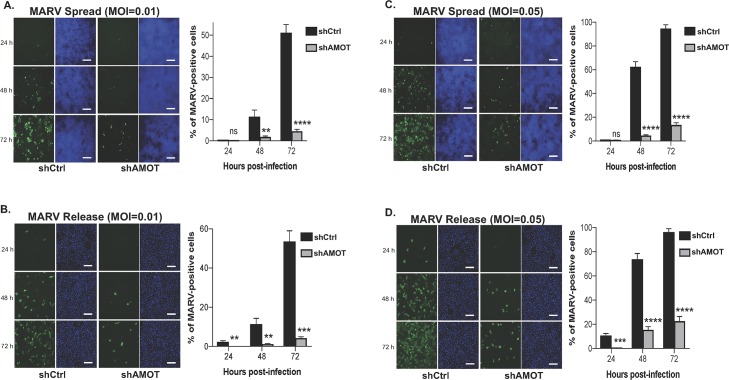
Spread and release of live MARV from shCtrl or shAmot cells.shCtrl or shAmot cells were infected with MARV at an MOI of either 0.01 (A and B), or 0.05 (C and D), and both virus spread (A and C) and release (B and D) were quantified at 24, 48, and 72 hours post-infection. MARV = green, Hoechst 33342-stained nuclei = blue. Bar graphs represent data from three independent experiments. Scale bars = 200 μm.